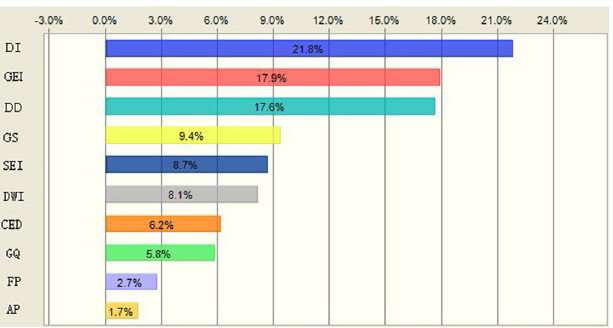
Fig 11. Sensitivity analyses on factors of relative risk models for representative points in Xinmin. DI, Relative groundwater vulnerability index; GEI, Groundwater exploitation intensity; DD, Drainage density; GS, groundwater supply; SEI, Sewage emission intensity; DWI, Dangerous waste intensity; CED, Chemical enterprise density; GQ, groundwater quality; FP, Forest proportion; AP, Agriculture proportion.